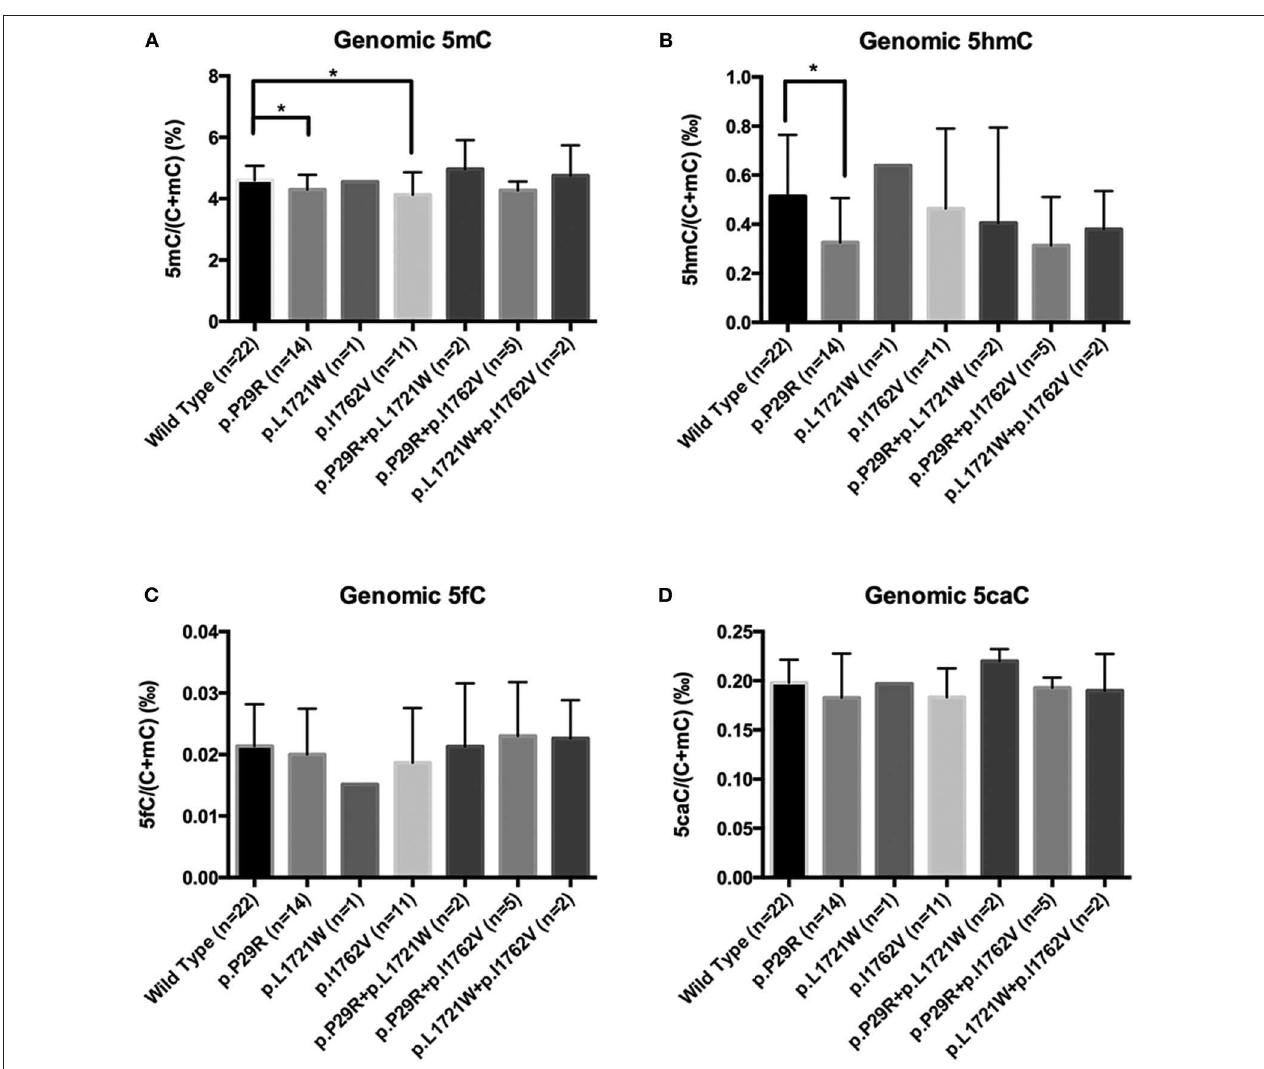
FIGURE 6 | Genomic 5mC, 5hmC, 5fC, and 5caC levels in NFPAs with various SNP sites. * P < 0.05. (A) Genomic 5mC levels in the TET2 p.P29R and TET2 p.I1762V groups were lower than that in the wild-type group. (B) Genomic 5hmC level in the TET2 p.P29R group was lower than that in the wild-type group. (C) There was no significant difference of 5fC among the 7 groups. (D) There was no significant difference of 5caC among the 7